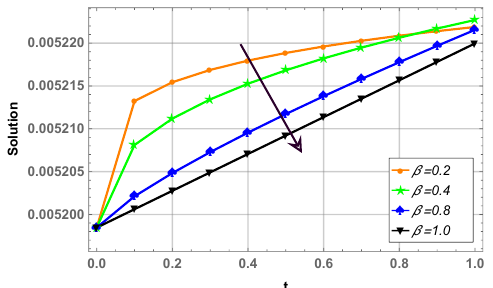
Figure 2. Effect of fractional parameter β on time-fractional Lax’s KdV equation (Example 3) when k = 0.1 and x = 10.